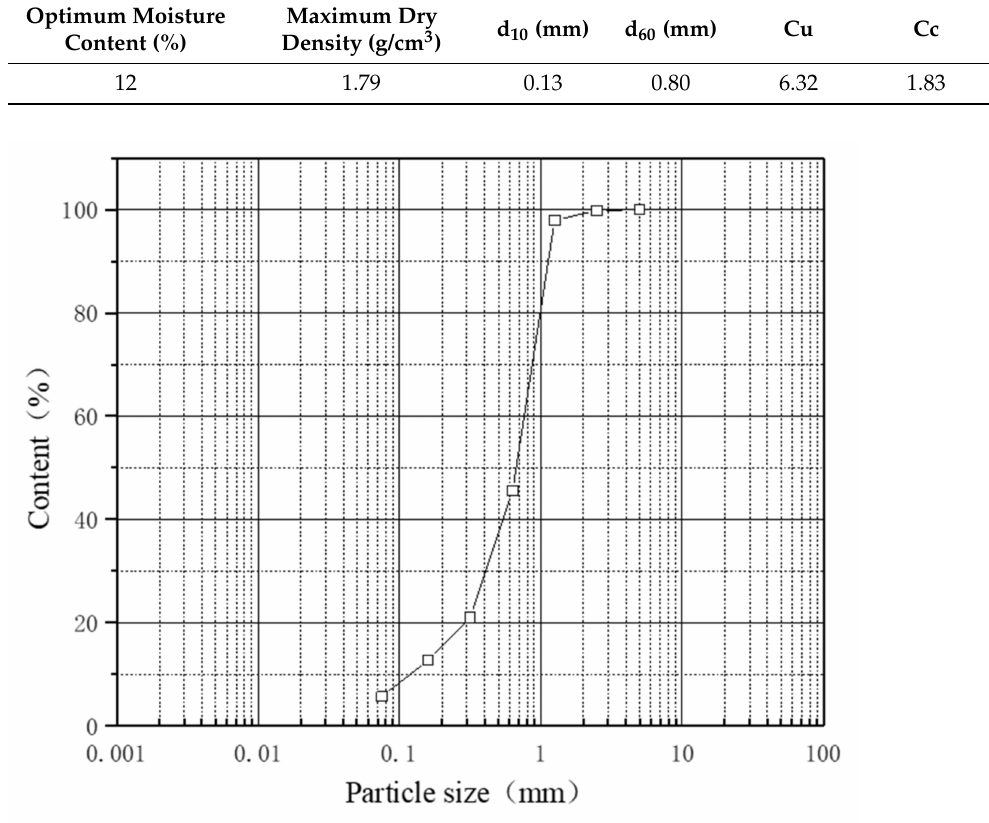
Figure 1. Grain size distribution curve of the coarse-grained soil.